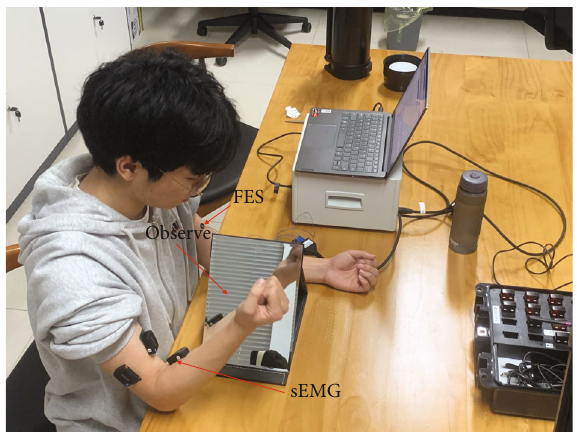
Figure 1: A subject in the experimental group undergoing rehabilitation